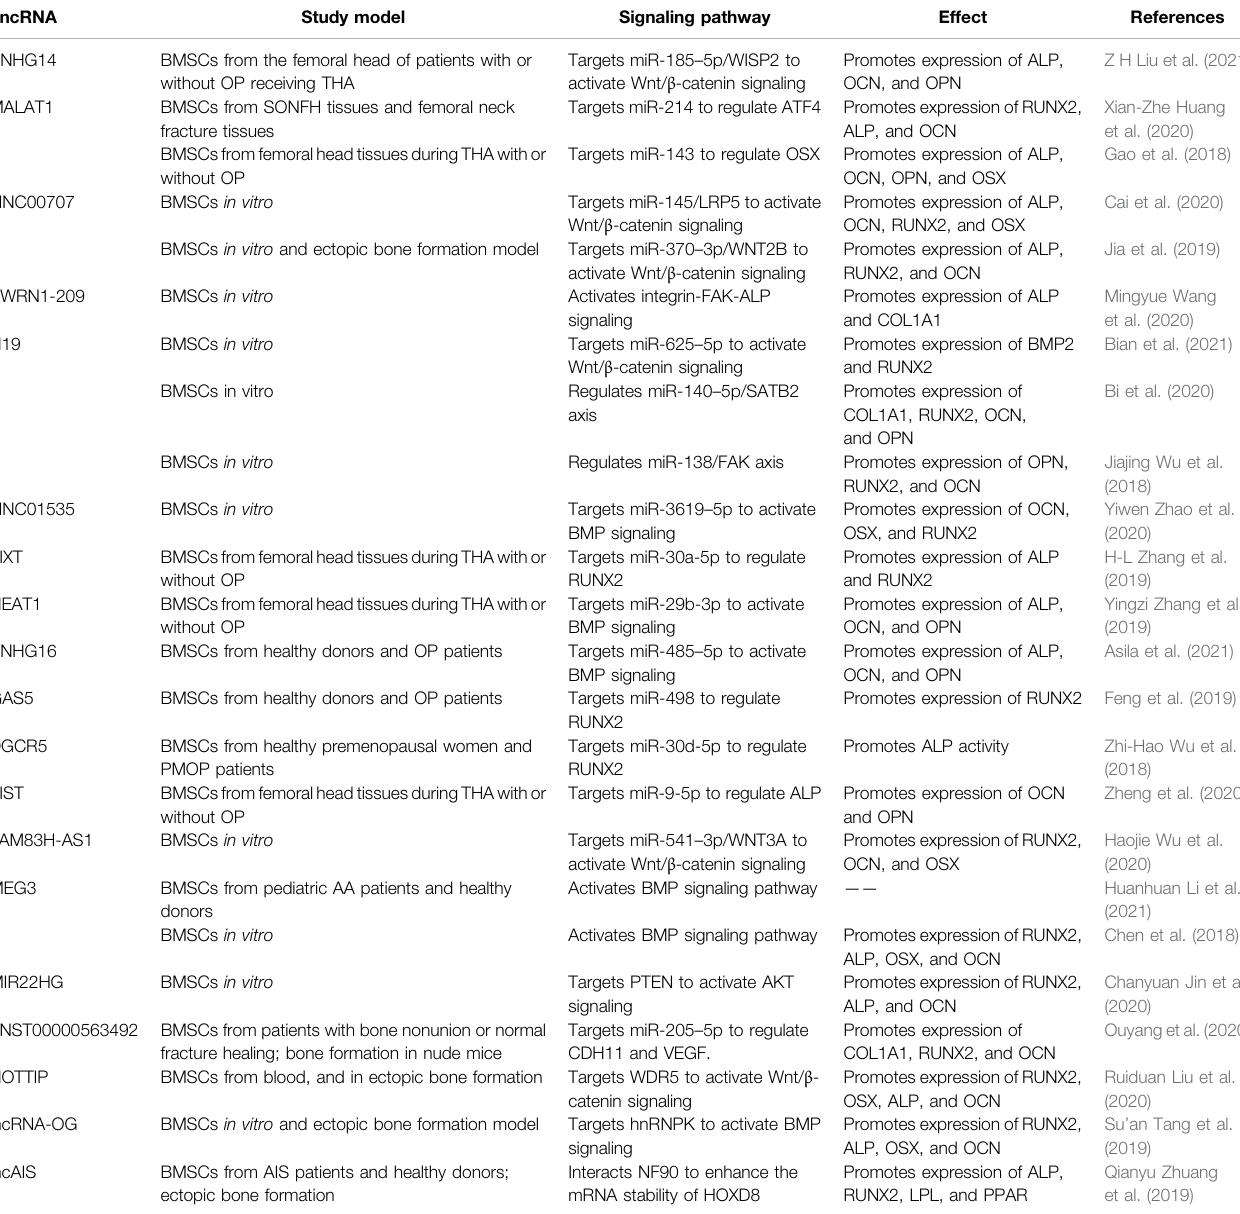
TABLE 3 | LncRNAs that promote osteogenic differentiation of BMSCs and underlying mechanisms.